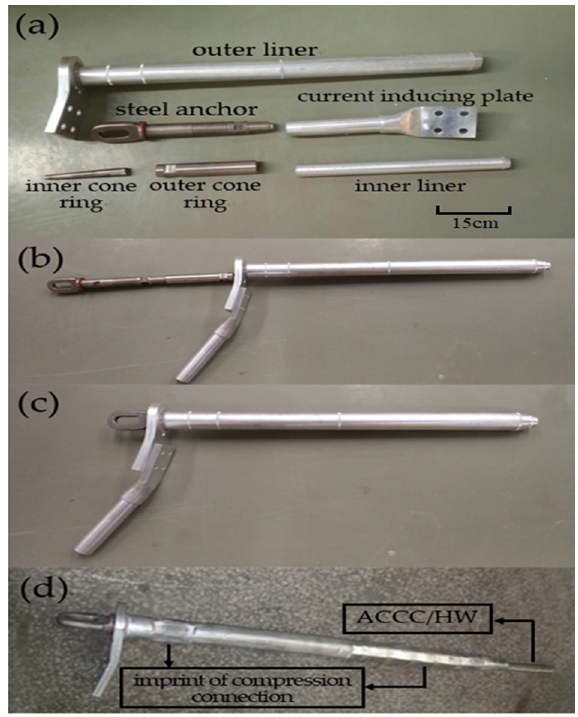
Figure 4. Special fittings used in this work. ( a ) detail sketch; ( b ) assembly process; ( c ) assembly process; ( d ) ready for use.